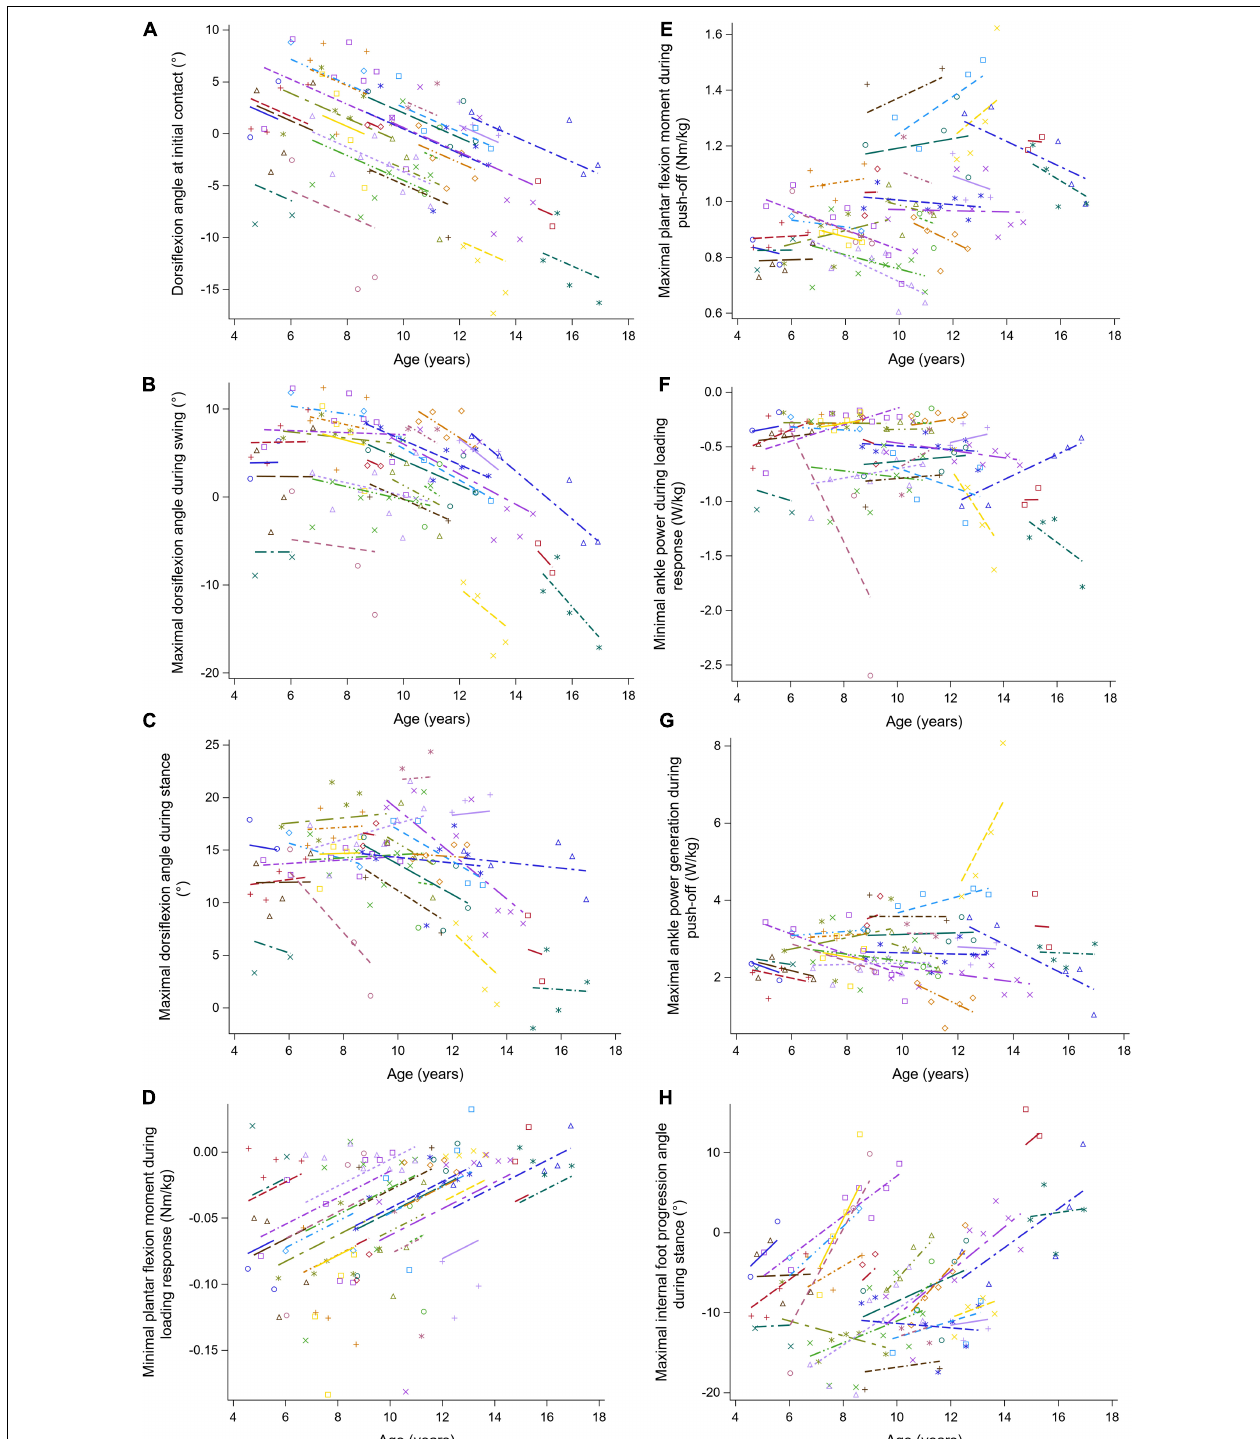
FIGURE 7 | The individual predicted profiles (dashed lines) for the dorsiflexion angle at initial contact (A) , maximal dorsiflexion angle during swing (B) , maximal dorsiflexion angle during stance (C) , minimal plantar flexion moment during loading response (D) , maximal plantar flexion moment during push-off (E) , minimal ankle power during loading response (F) , maximal ankle power generation during push-off (G) , and maximal internal foot progression angle during stance (H) . The actual observed values are visualized by the symbols. Each color represents one patient with DMD. The regression coefficients of the fixed effects are given in Table 7 . DMD, Duchenne muscular